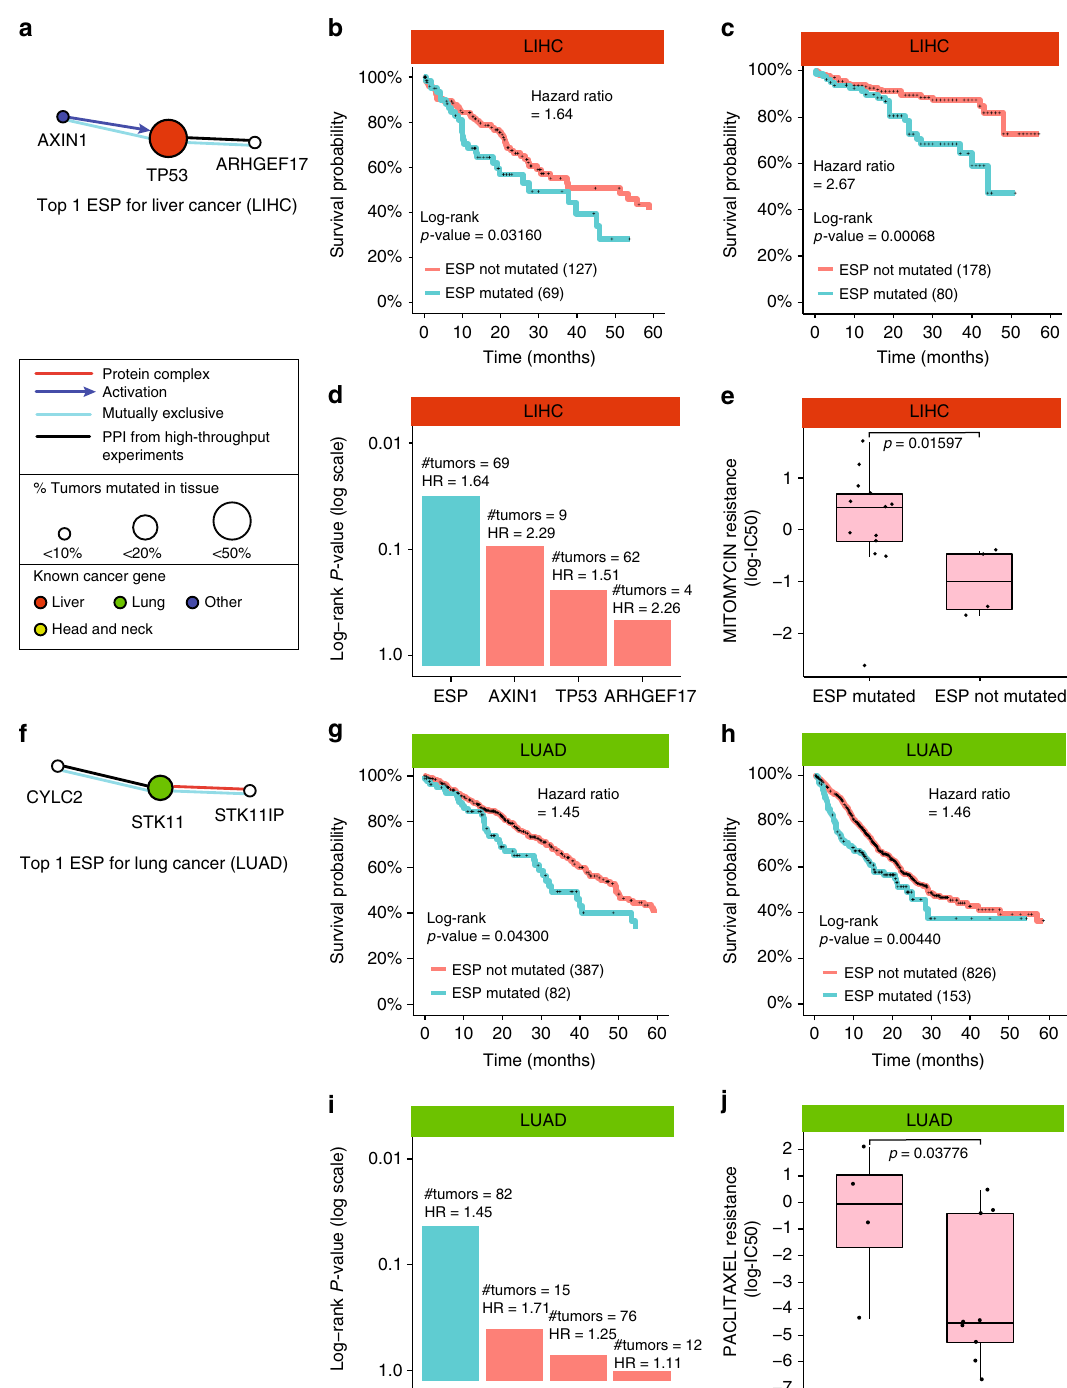
HR = 1.25 #tumors = 12 HR = 1.11